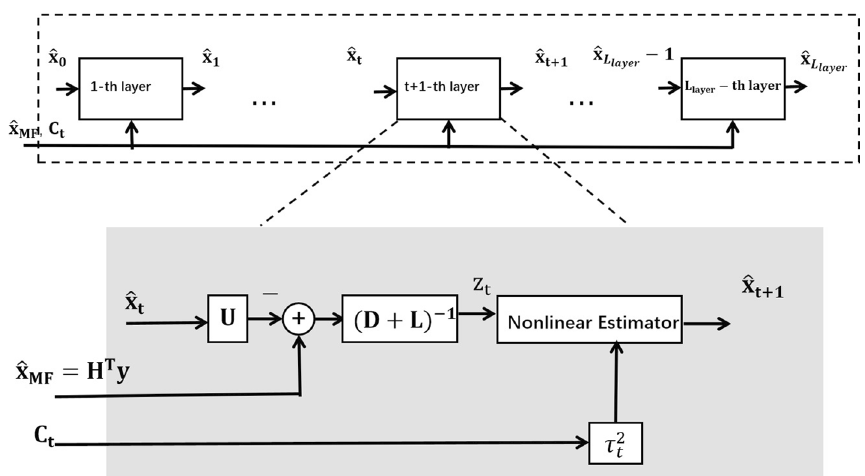
Fig. 6 Structure of